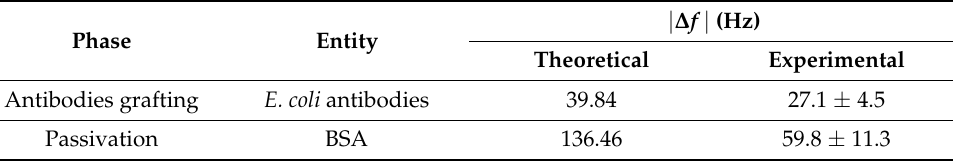
bio-functionalization procedure of ZnO/GaAs biosensor (220 µ m thick membrane) operating at the resonant frequency of 6.35 MHz ( n = 3